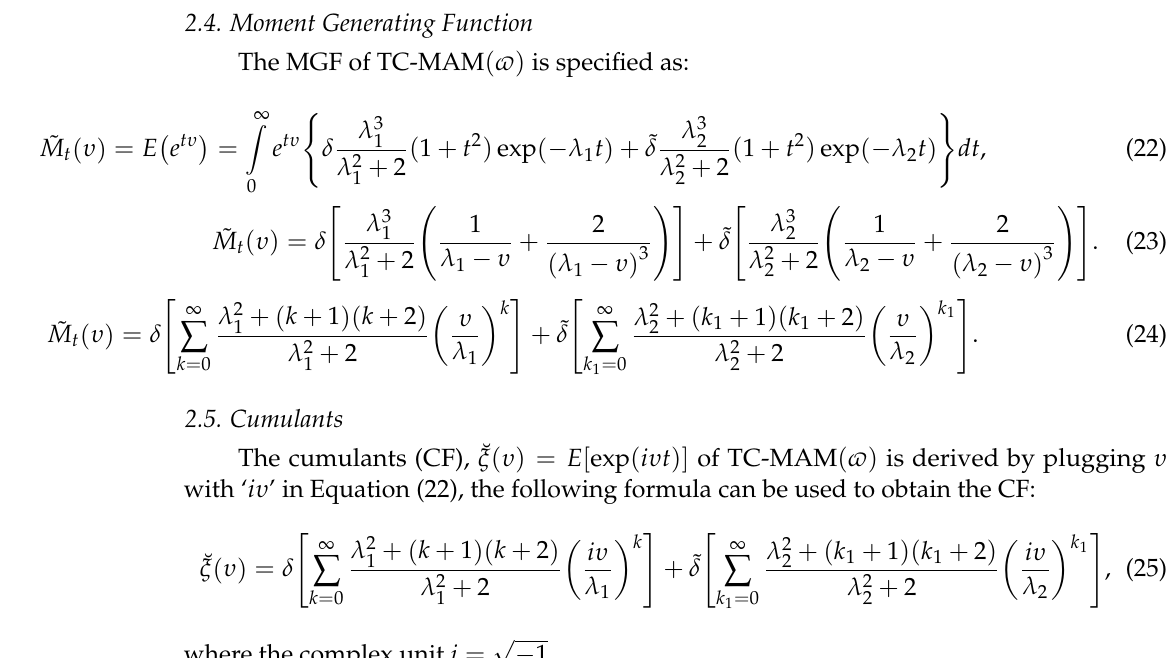
Figure 7. Behavior of coefficient of kurtosis ( K ) of TC-MAM ( (cid:118) )